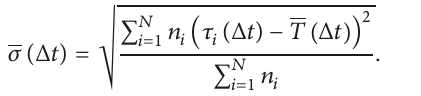
based on trajectory analysis [35]. The average traffic density of link 𝑗 𝑘 𝑗 during time interval Δ𝑡 is estimated as the total time spent on the link during the time